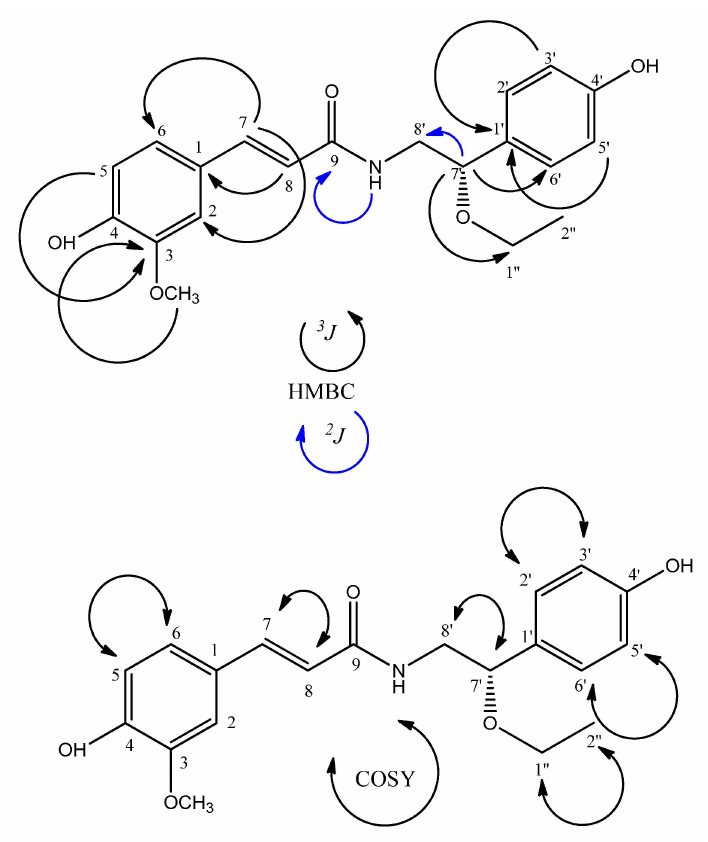
Figure 2. Compound 9 HMBC ( 3 J and 2 J ) and COSY